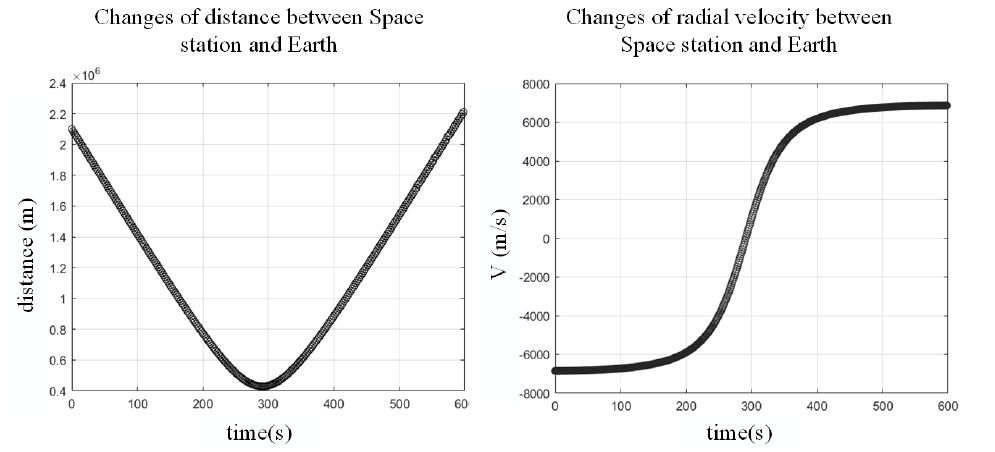
Figure 1. Satellite-ground distance and radial velocity variation of the space station obtained by STK simulation.